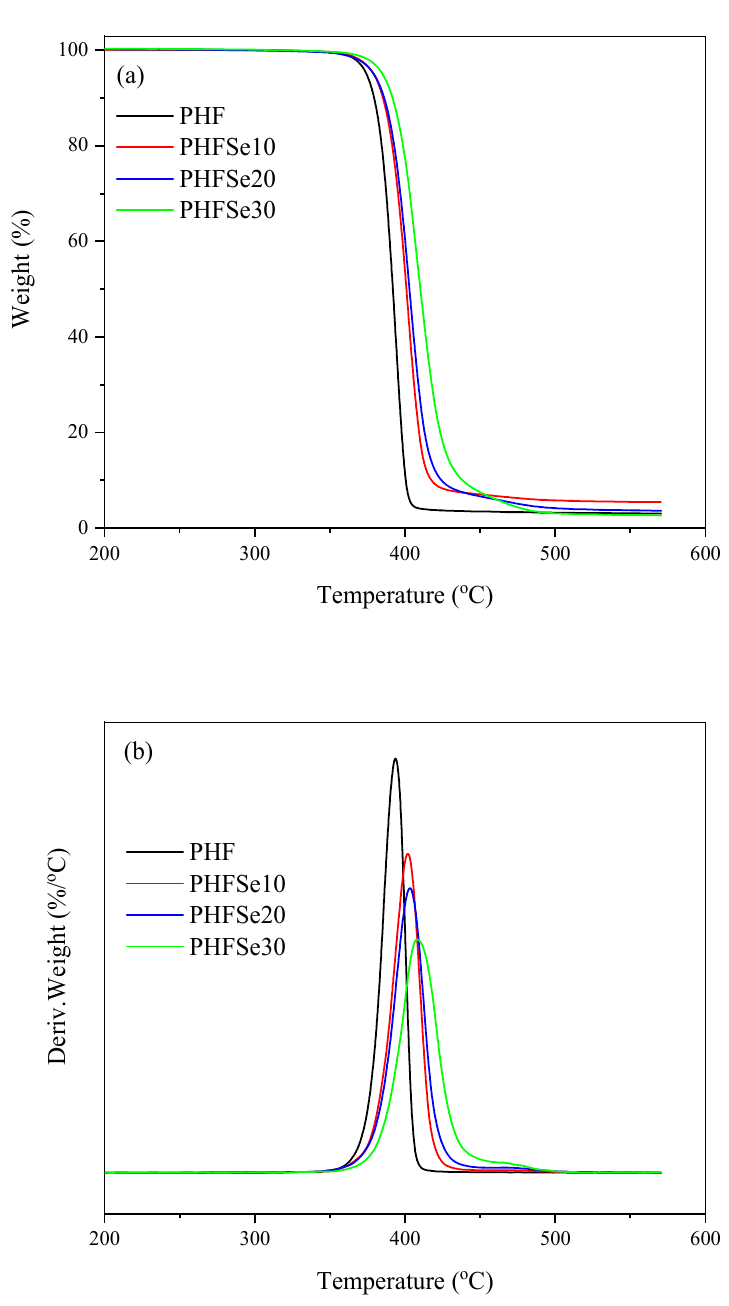
Figure 2. Thermal stability study of PHF and PHFSe copolyesters: ( a ) TGA and ( b ) DTG curves. In this section, the basic thermal behavior of PHF and PHFSe copolyesters was stud- ied with DSC. Figure 3 shows the DSC traces of PHF and PHFSe copolyesters at a heating rate of 20 °C/min after a melt-quenching process. The T g of PHF was 12.3 °C, while the T g of PHFSe copolyesters obviously shifted downward to a low temperature range with in- creasing the HSe unit content due to the increased the chain mobility. Both PHF and PHFSe polyesters showed the cold crystallization and subsequent melting behavior dur- ing the second heating process. The cold crystallization temperature ( T ch ) of PHF was 55.4 °C, while it gradually changed to 40.4 °C, 33.1 °C, and 22.3 °C for PHFSe10, PHFSe20, and PHFSe30, respectively. The cold crystallization enthalpy ( Δ H ch ) values were also meas- ured. In addition, the T m of PHFSe30 significantly decreased to 111.2 °C; furthermore, the melting enthalpy ( Δ H m ) decreased from 48.1 J/g for PHF to 35.3 J/g for PHFSe30 due to the copolymerization. As a result, the thermal properties of PHF may be obviously influenced and easily adjusted through copolymerization with SeA as the third comonomer in this research.